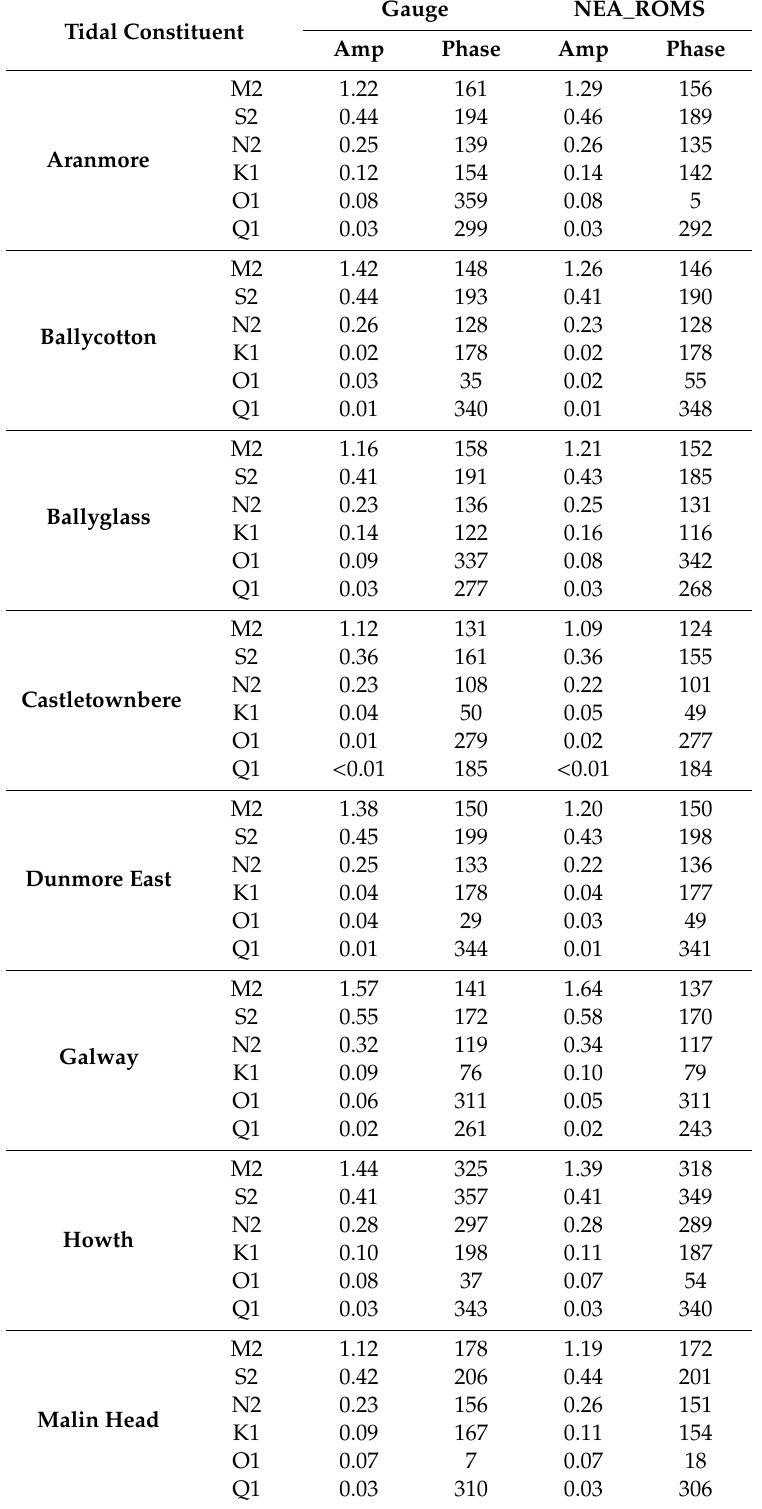
Table 2. The amplitudes in meters and phases in degrees for six of the principal tidal constituents calculated, for the measured and modelled